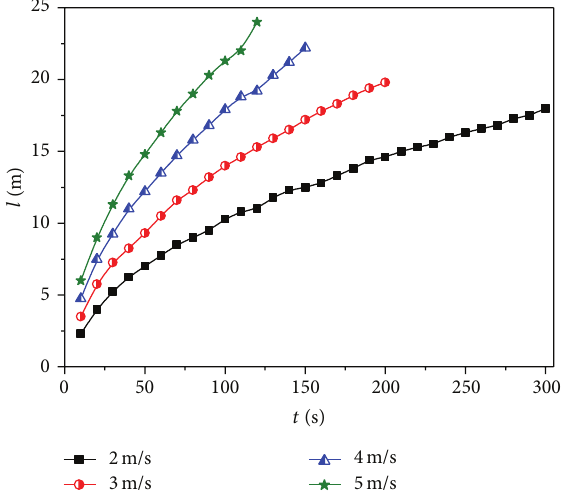
Figure 11: The gas mixture length varied with time at different inlet rates.